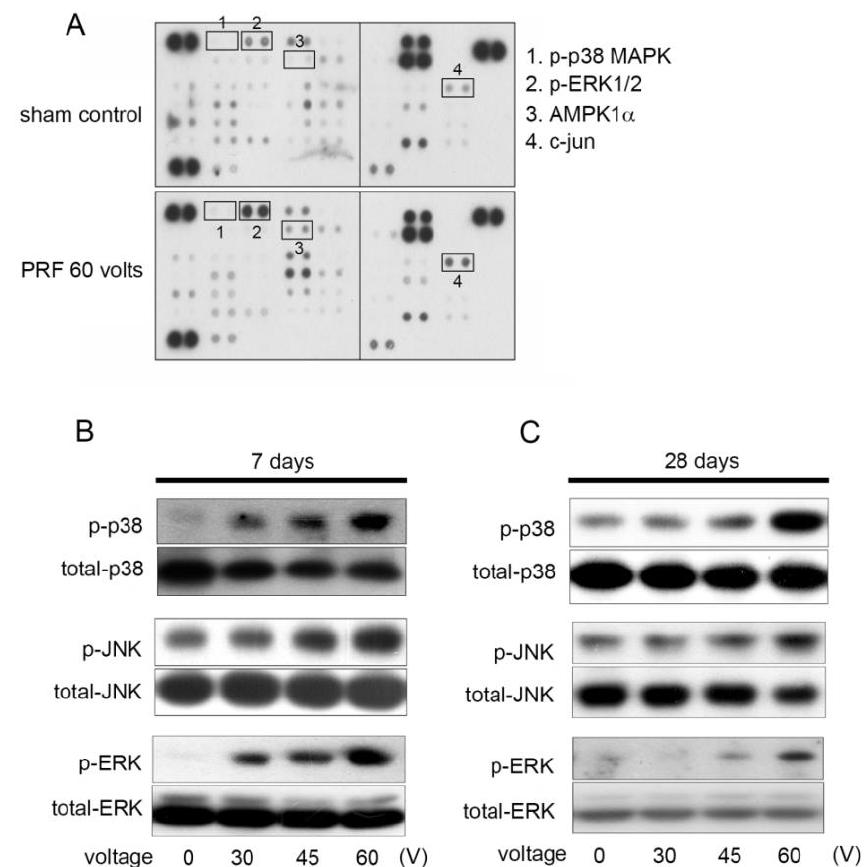
Figure 2. Phosphokinase activity assay and Western blot analysis of MAPKs activation in the lumbar dorsal horn of PRF-stimulated rats. ( A ) Template showing the location of specific antibodies (1, phosphor-p38 MAPK; 2, phosphor-ERK1/2; 3, AMPK1 α ; 4, c-jun) spotted onto the membrane. Each antibody was spotted in duplicate. The marked activations of phospho-MAPKs in response to 60 V of PRF stimulation are indicated by Arabic numerals. ( B , C ) Rats were stimulated with PRF at the indicated intensities (30 V, 45 V, and 60 V), followed by 7 or 28 days of rest. Then, the left dorsal horn of the rats was harvested and subjected to Western blot analysis. The phospho-p38 MAPK, phospho-ERK1/2, and phospho-JNK/SAPK were identified. The total-p38 MAPK, total-ERK1/2, and total-JNK/SAPK were used as a loading